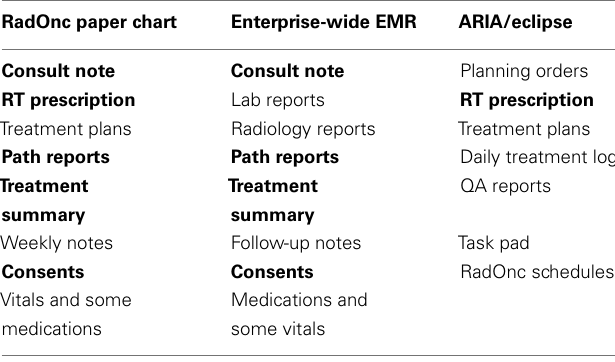
Table 1 | Distribution of patient/treatment information in our department pre-implementation of a radiation oncology EMR.